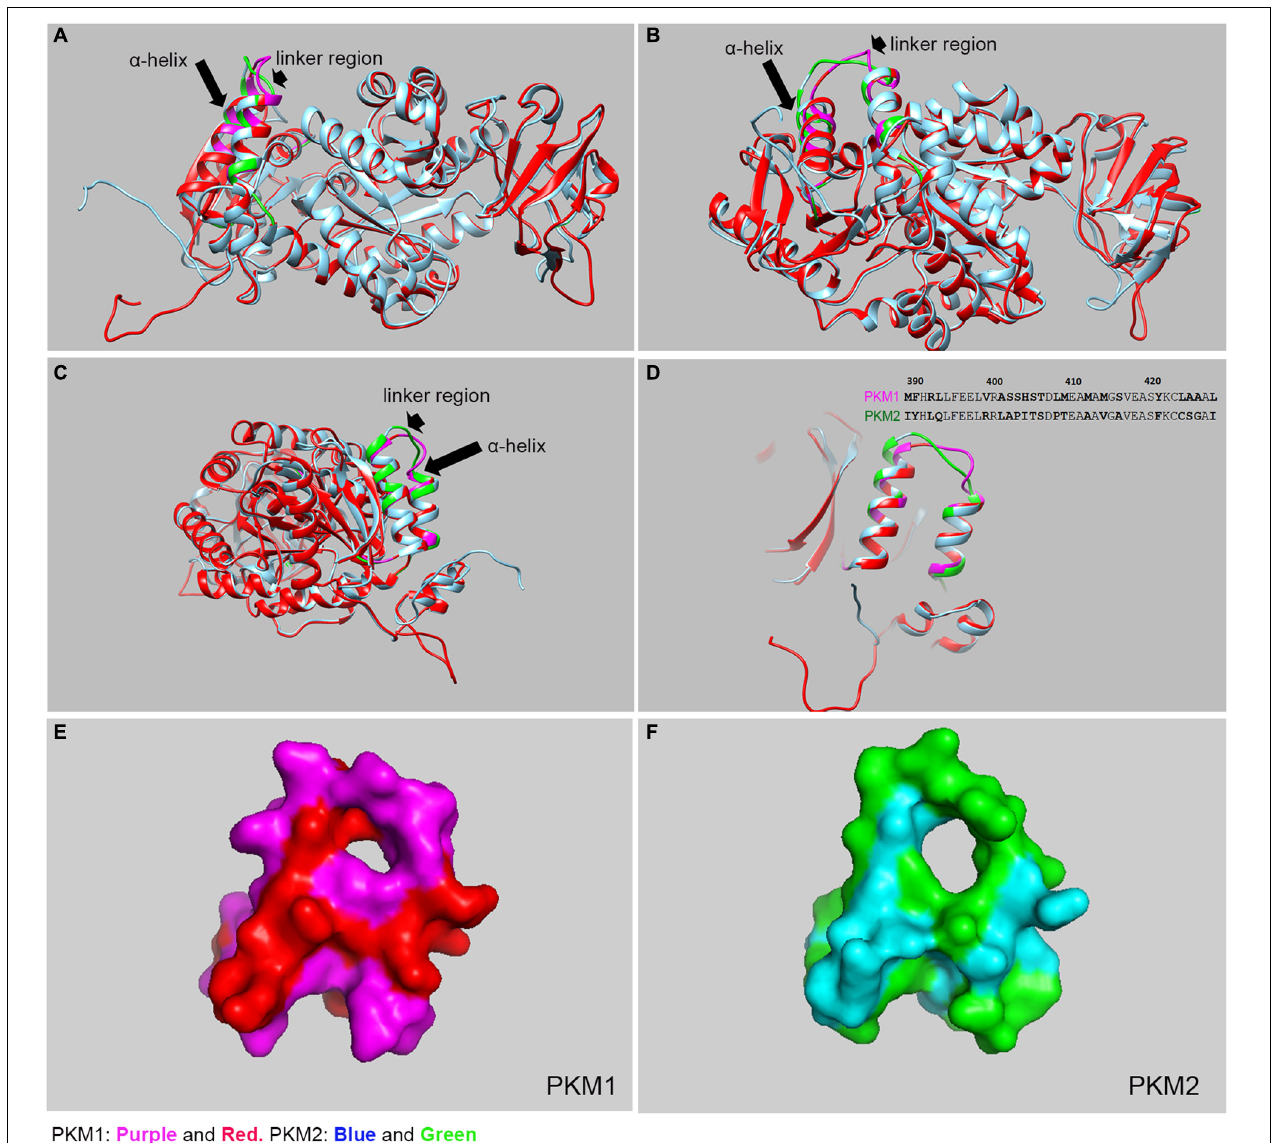
FIGURE 2 | Structural comparison between mouse PKM1 and PKM2. The crystal structure of human PKM1 and PKM2 has been solved (PDB ID: PKM2, 4JPG, PKM1, 3SRF). We carried out the molecular modeling of mouse PKM1 and PKM2 using the Raptor X template-based protein structure modeling web server and aligned, with Clustal Omega, and the resulting structures were generated using the UCSF Chimera program and PyMOL (PyMOL Molecular Graphics System, Version 4.5 Schrödinger, LLC). The structural alignment of PKM1 and PKM2 at the different views (A–C) . The purple color represents PKM1 divergent region/residue and the red represents PKM1 conserved region/residue. The green color represents the PKM2 divergent region/residues and the blue represents PKM2 conserved region/residue. The majority of residues in PKM1 are identical to PKM2, except a region where diverge can be noticed in the linker region (see arrowhead) and 2 alpha helices (see arrow). A significant divergence was shown to be localized to residues 389–428 which consist of 2 alpha helices and joining linker region (D) . inset: Divergent protein sequence between PKM1 and PKM2 (389–428). The surface plots of PKM1 (E) and PKM2 (F) , respectively as seen in panel (D)